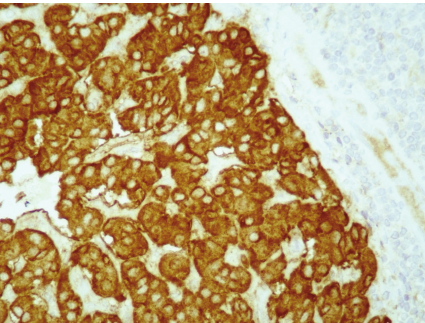
Figure 4: On immunohistochemical examination the cells stained positive for chromogranin (DAB ×